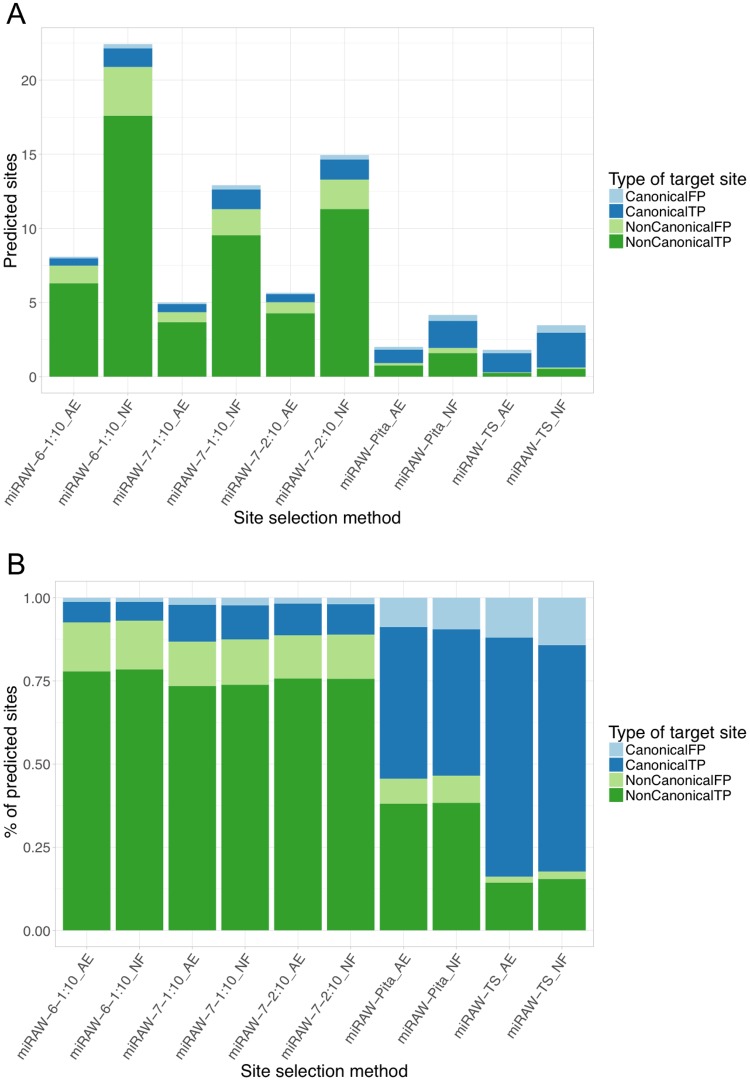
Composition of site types identified by the different CSSMs implemented in miRAW.(a) Average number of miRNA binding sites (MBSs) identified by the different CSSMs in a miRNA:mRNA pair. Blue color refer to MBS following a canonical structure, green refer to non-canonical sites; darker colors correspond to positive sites predicted in experimentally verified functional miRNA:mRNA pairs (true positives), lighter colors refer to positive sites identified in non-functional pairs (false positives). (b) Proportion of canonical, non-canonical, true positive and false negative sites identified by each of the candidate site selection methods. Figures illustrate that miRAW-Pita and miRAW-TS CSSMs are strongly biased towards detection of canonical sites whereas miRAW specific CSSMs detect a higher proportion of non-canonical sites.